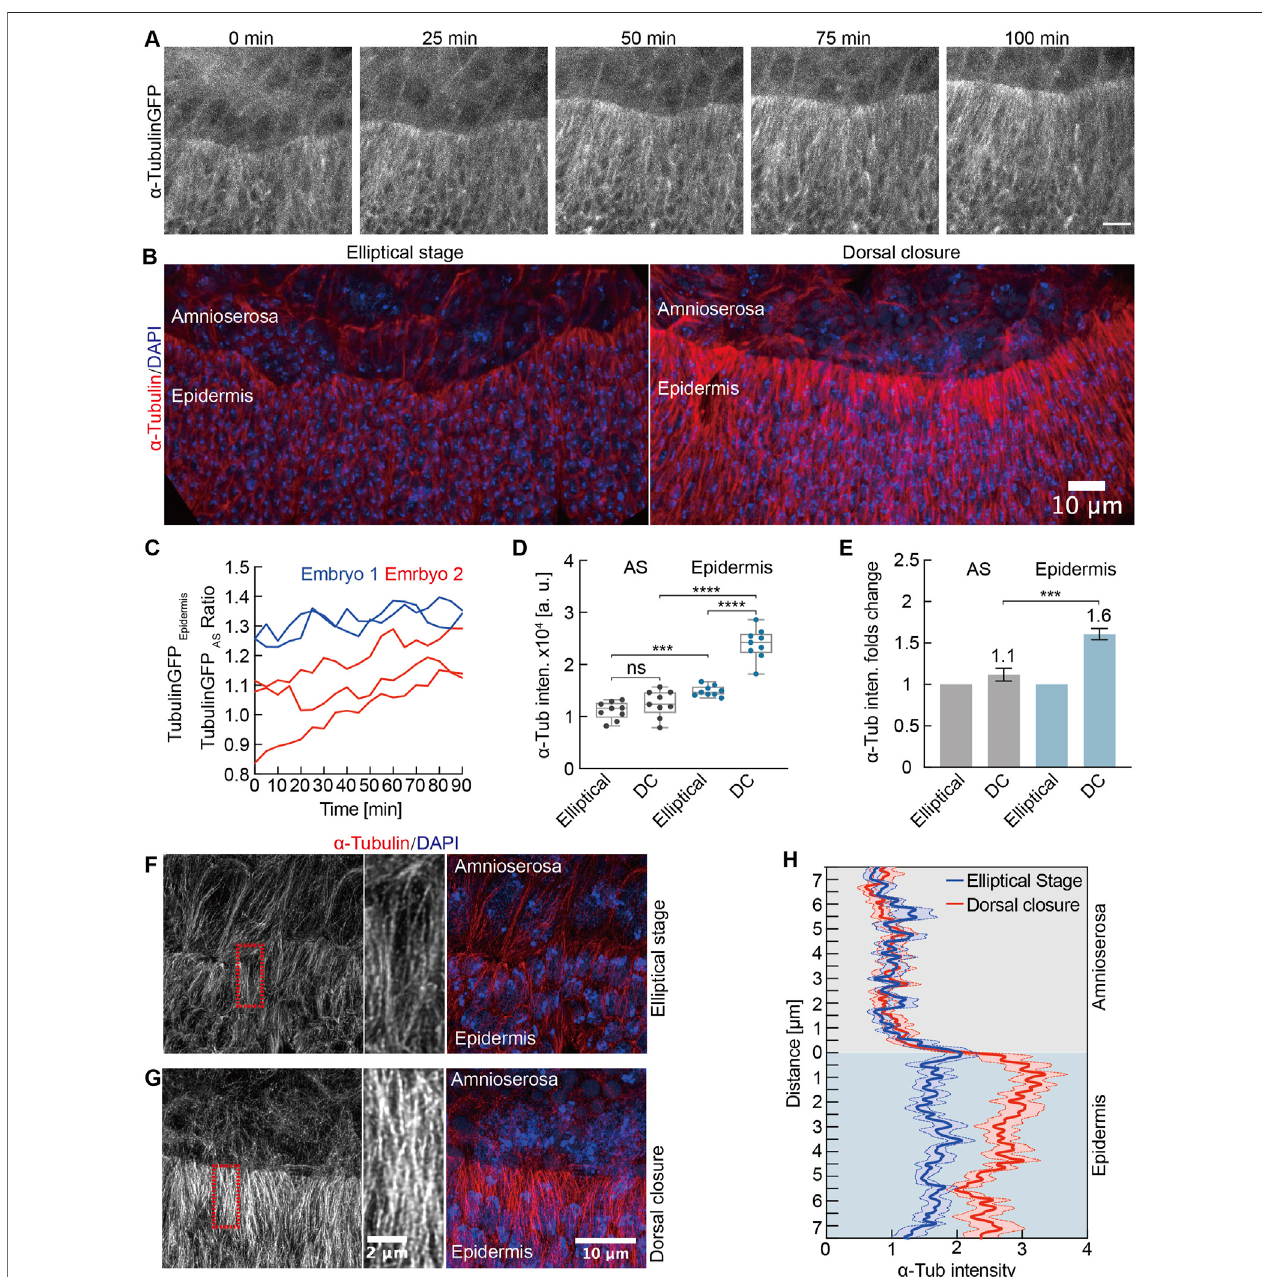
FIGURE 7 | Developmental upregulation of microtubules in lateral epidermal cells. (A) Maximum intensity projections from a time-lapse recording of an embryo expressing alpha-Tubulin-GFP undergoing dorsal closure; 0 min, the fi rst frame of the recording. Scale bar, 10 μ m. (B) Maximum intensity projections of alpha-Tubulin staining during the elliptical stage and dorsal closure. DAPI stained DNA. (C) Time course of the alpha-Tubulin-GFP intensities as the ratio between the signal in lateral epidermis and AS. Each curve represents an independent measurement. (D) Quanti fi cation of alpha-Tubulin intensities in AS and lateral epidermal cells during the elliptical stage and dorsal closure (DC). Boxes, second and third quartiles; whiskers, the min to the max; horizontal line, median; dots, individual data. N = 9 from three embryos,threeindependentmeasurementsfromeachembryofromeachtissueandstage. (E) Quanti fi cationofalpha-TubulinintensitiesinASandlateralepidermalcells normalized to the elliptical stage. Two-way ANOVA estimates the p values, *** p < 0.001, **** p < 0.0001, ns, nonsigni fi cant. (F,G) High-resolution images of the microtubules. Insets in high magni fi cation as indicated by dashed boxes (red). (H) Line pro fi les of alpha-Tubulin staining over the tissue interphase. Mean (bold line) with SEM (ribbon band) of 12 pro fi les from three embryos at each stage, four independent pro fi les from each embryo at each stage.